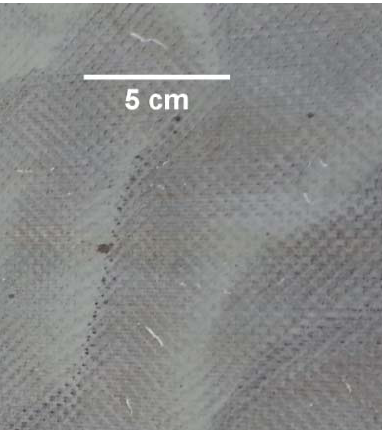
Figure 7. Image of hydrophobic PTFE membrane after treatment of textile wastewater.